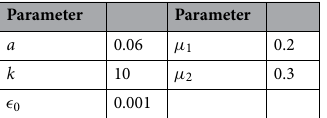
Table 3. This table lists the model parameters used for all simulations of the Aliev–Panfilov